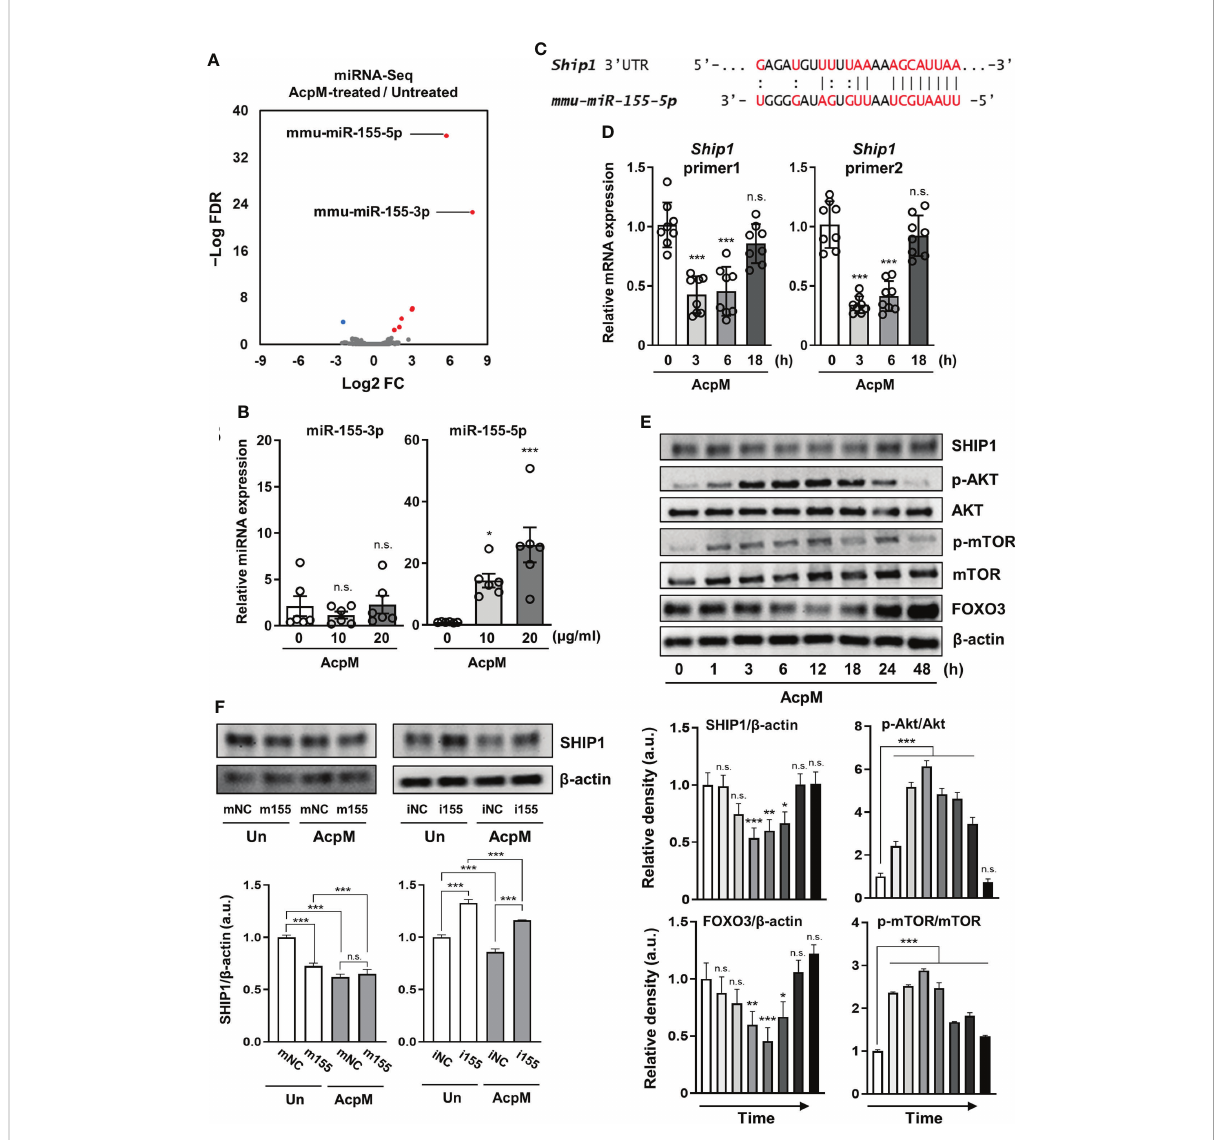
FIGURE 5 AcpM suppresses SHIP1 by increasing miR-155 expression. (A) A volcano plot representing differentially expressed miRNAs with the log2-fold change (FC) plotted against the negative log10 false discovery rate (FDR) for the AcpM-treated group compared to the untreated group. Red and blue dots indicate upregulated and downregulated genes, respectively. (B) BMDMs were treated with recombinant AcpM (10 or 20 m g/ml) for 8 h and the cell lysates were subjected to qRT-PCR analysis to measure the miR-155-3p and miR-155-5p expression. (C) The 3 ′ UTR of ship1 mRNA is shown schematically, along with the relative location of the mouse miR-155-5p binding site. (D , E) BMDMs were treated with recombinant AcpM (10 m g/ml) for indicated times, and the harvested cells were subjected to either qRT-PCR analysis to determine the gene expression of Ship1 (D) or immunoblot analysis to measure the expression of SHIP1 and SHIP1-downstream signaling molecules (E) . The representative image ( E , upper panel) and the densitometric analysis ( E , lower panel) of protein bands were presented. (F) BMDMs were transfected with mNC, m155, iNC, or i155, then further treated for 8 h with recombinant AcpM (10 m g/ml). Cells were lysed and subjected to immunoblot analysis to determine the SHIP1 protein level. The representative image (upper panel) and the densitometric analysis (lower panel) of SHIP1 bands were presented. Statistical analysis was determined with an unpaired t -test or one-way ANOVA and presented as means ± SD from at least three independent experiments performed. * p < 0.05; ** p < 0.01; *** p < 0.001. a.u., arbitrary unit; n.s., not signi fi cant; mNC, negative control of miR-155-5p mimic; m155, miR-155-5p mimic; iNC, negative control of miR-155-5p inhibitor; i155, miR-155-5p inhibitor. Un, untreated; AcpM,